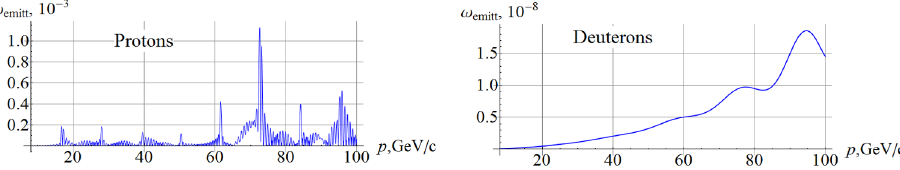
Figure 2. Incoherent part of the resonance strength for protons and deuterons at the